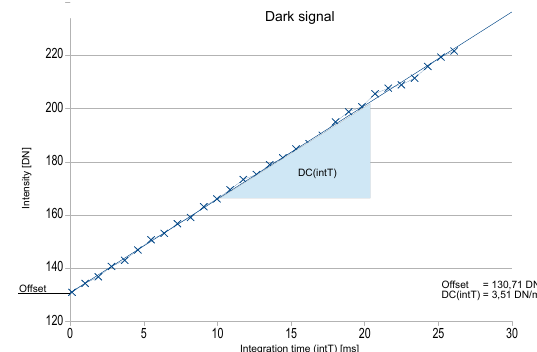
Figure 2: Dark Signal of one representative Pixel. 100 images for each integration time were used.